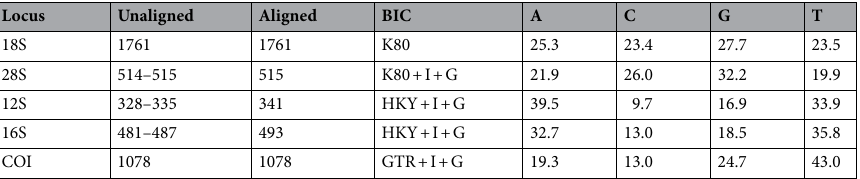
Table 1. Statistics for nuclear loci, 18S rDNA (18S) and 28S rDNA (28S), and mitochondrial loci, 12S rDNA (12S), 16S rDNA (16S) and Cytochrome c Oxidase subunit I (COI) in divergence time estimation analysis of Asian forest scorpions (Scorpionidae: Heterometrinae): length (nucleotide base-pairs) of unaligned and aligned sequences; percent of each nucleotide; and model selected for BEAST analysis using the Bayesian Information Criterion